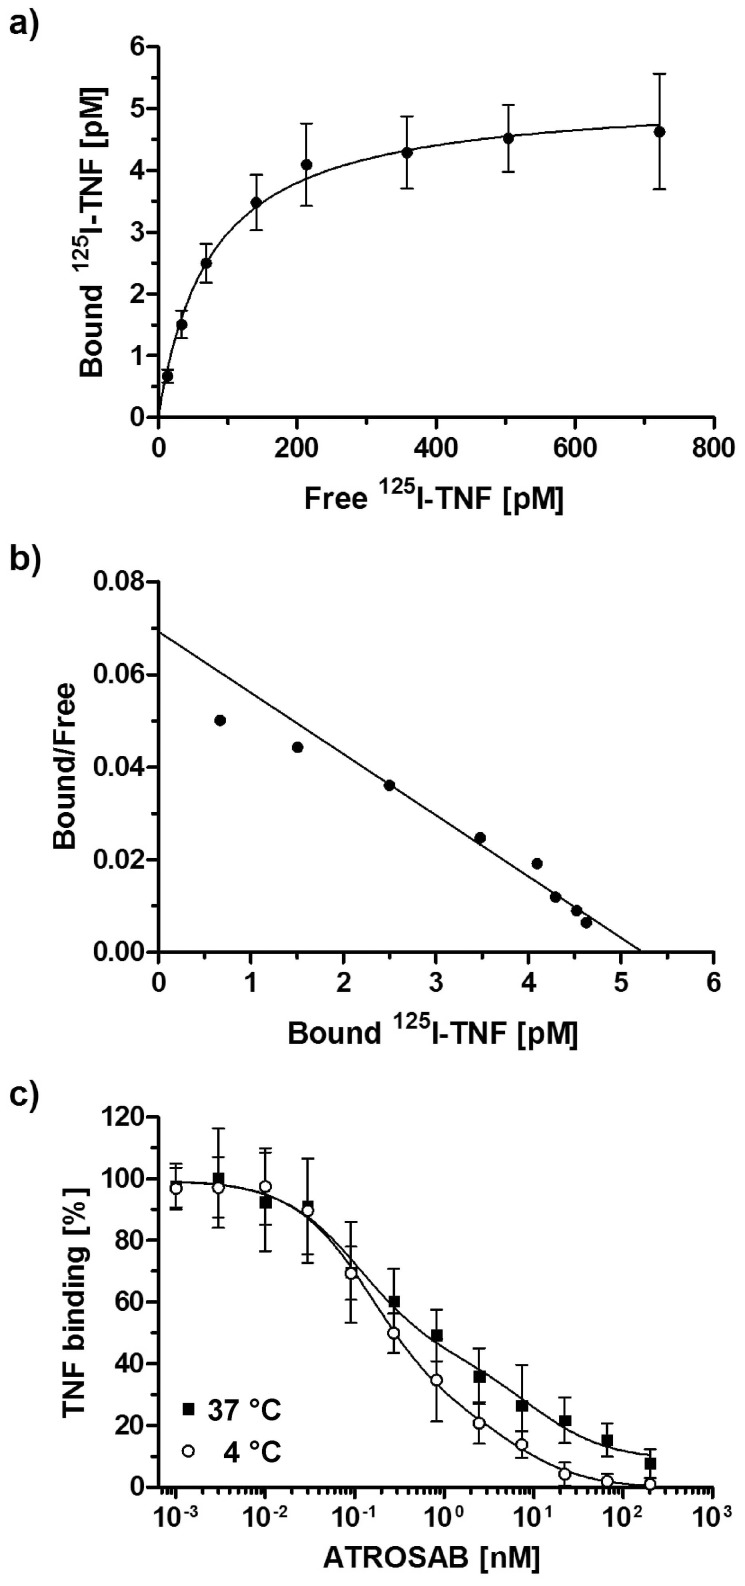
Inhibition of 125I-TNF binding to HT1080 cells by ATROSAB.a) Binding of 125I labeled TNF to HT1080 cells. b) Scatchard blot of binding of 125I labeled TNF to HT1080 cells. c) Inhibition of binding of 125I labeled TNF to HT1080 cells by ATROSAB at 4°C and 37°C, respectively. Displayed are mean values and SD of three individual experiments in percent of maximal TNF binding.